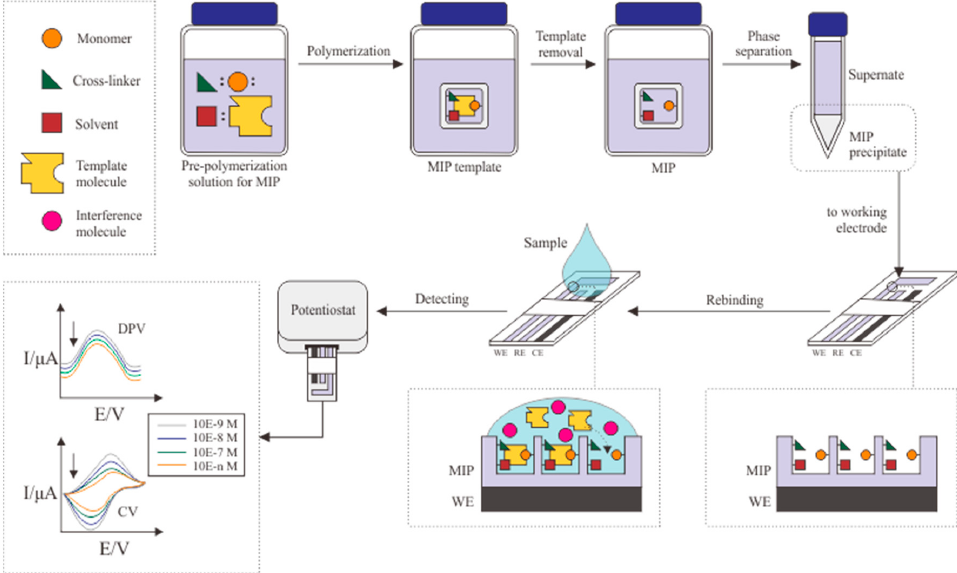
Figure 3. Schematic illustration of bulk imprinting method.